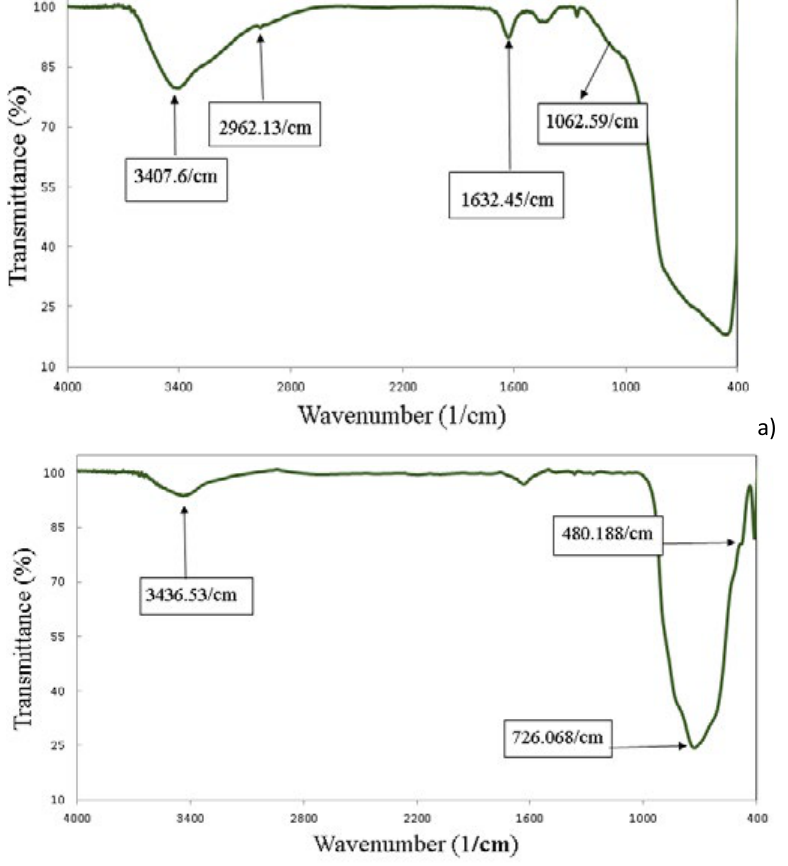
Fig. 5: FTIR (Fourier Transform Infrared Spectroscopy) spectra of: a) TiO 2 , and b) BiVO 4